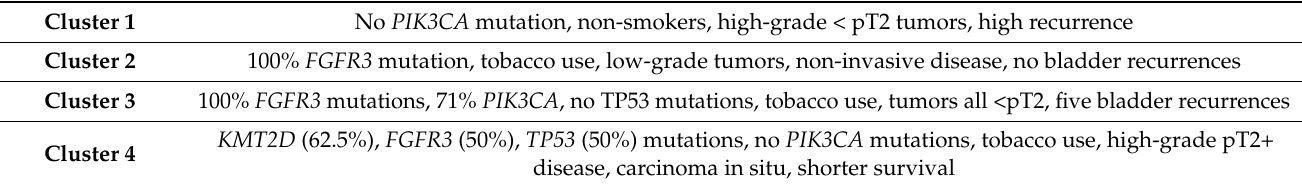
Table 5. Proposal of four clinical and molecular subtypes of urothelial cancer (UC) of the upper urinary tract (UUT) [81]. Cluster